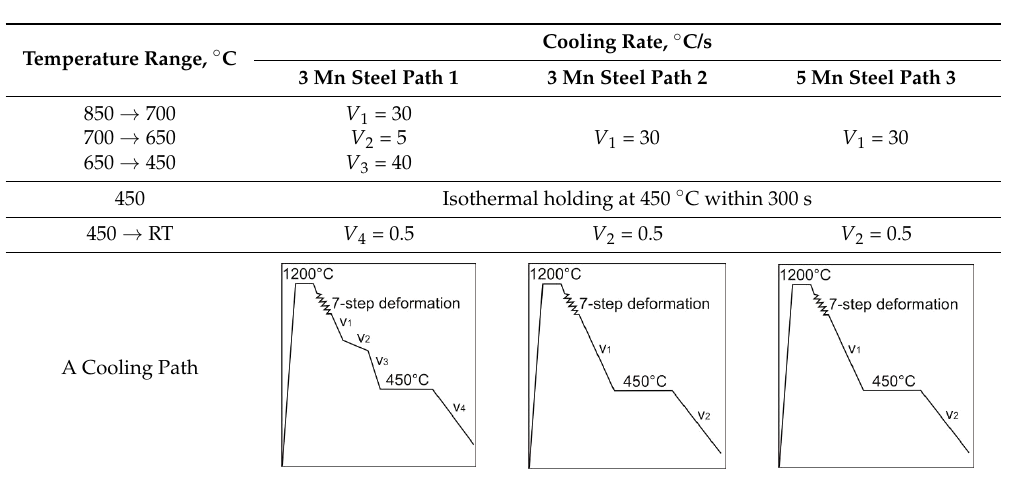
Figure 11. Microstructures obtained after deformation dilatometry tests for various cooling rates: ( a ) and ( d ) 0.5 °C/s; ( b ) and ( e ) 1 °C/s; ( c ) and ( f ) 4 °C/s. Table 3. Cooling schedules following the multistep Gleeble simulations.